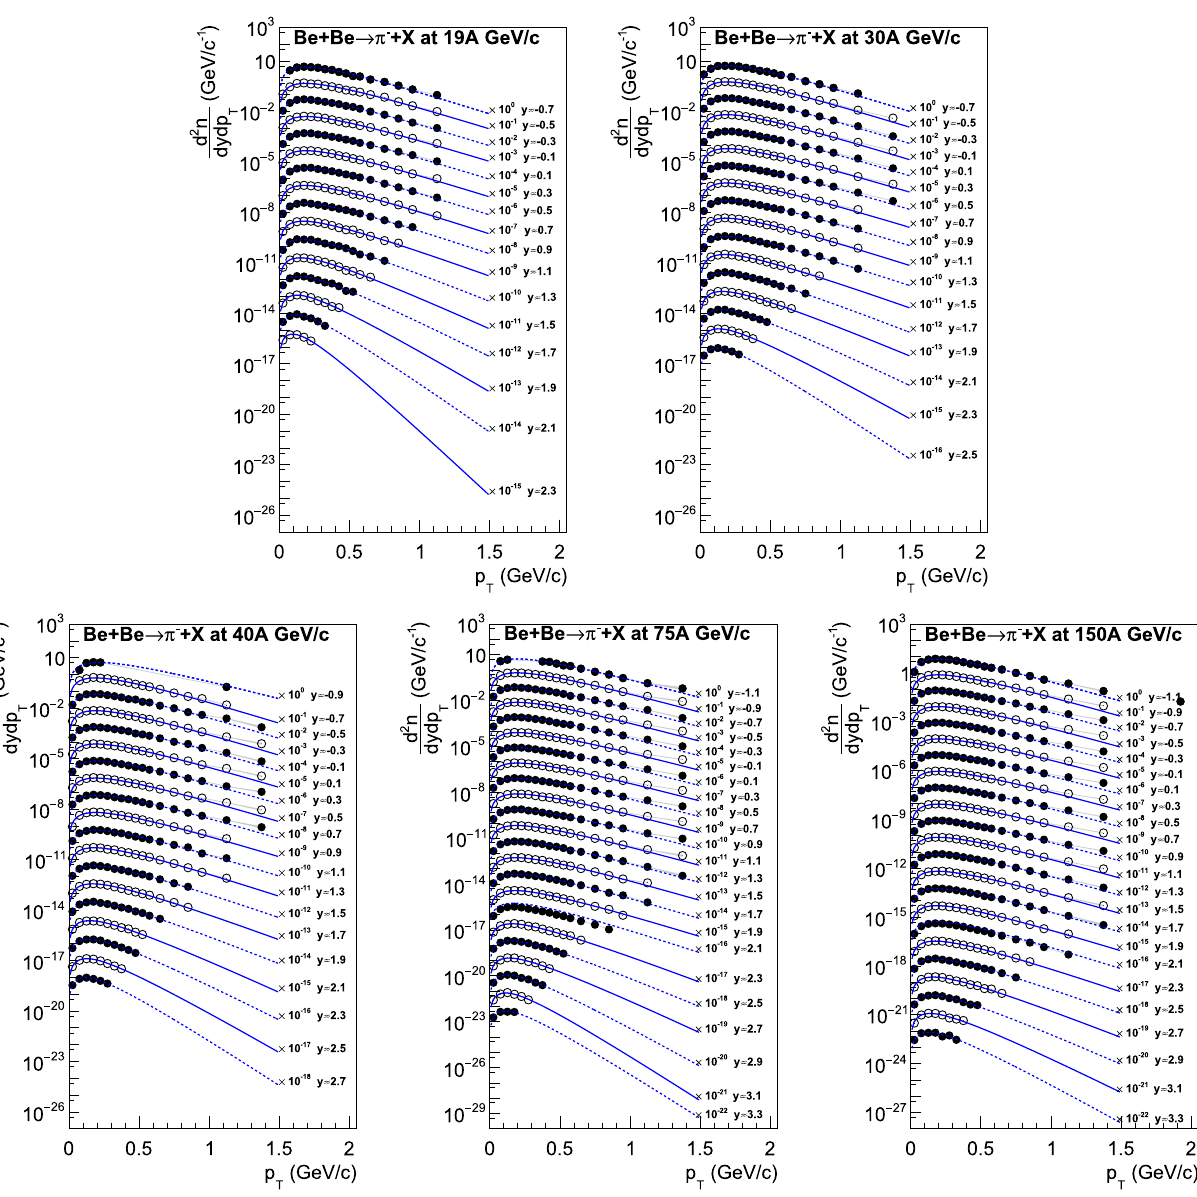
Fig. 11 Transverse momentum spectra of π − in rapidity slices pro- duced in the 5% most central Be + Be collisions. Rapidity values given in the legends correspond to the middle of the corresponding interval.